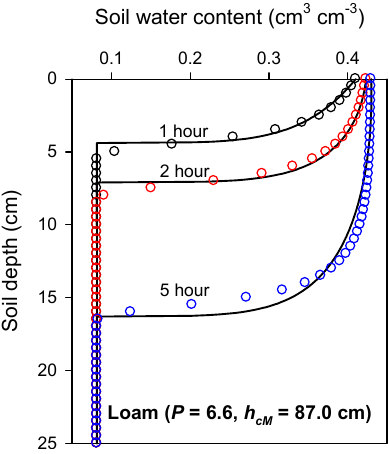
Figure 3. The best fit of Equation (21) (lines) to HYDRUS-1D simulation results (circles) for a constant-flux (= 1 cm h − 1 ) infiltration process into a loam soil with parameters given in Table 1.